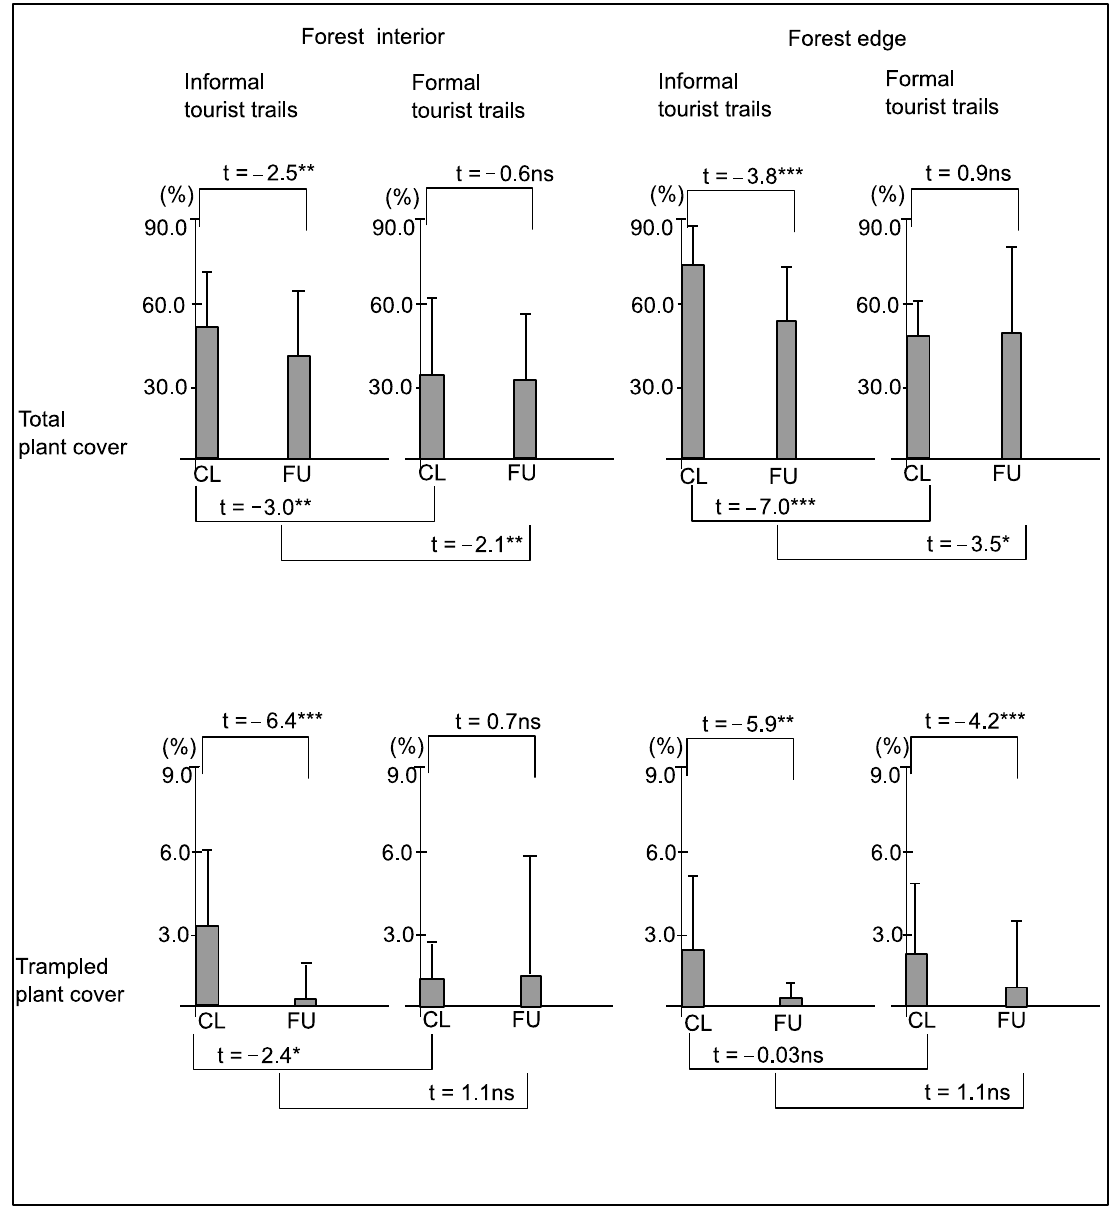
Figure 8. The mean values of total plant cover (±SD) and the percentage of plant cover damaged by trampling in closer (CL) and further (FU) plots located along informal (width < 50 cm) and formal (width > 150 cm) tourist trails within the forest interior and forest edge sites. The statistical significance level is explained in Figure 2.